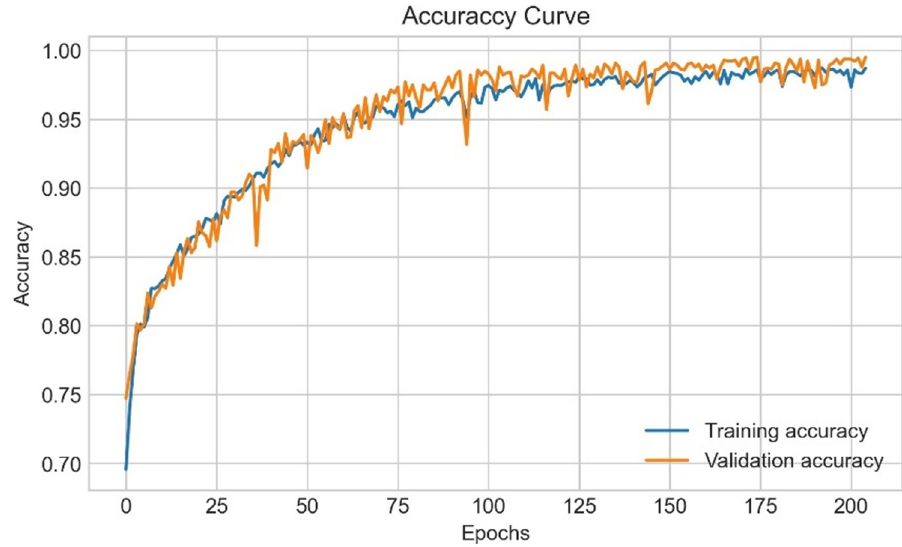
Fig 25. Training and validation accuracy curve of 200 epochs for Adam with learning rate